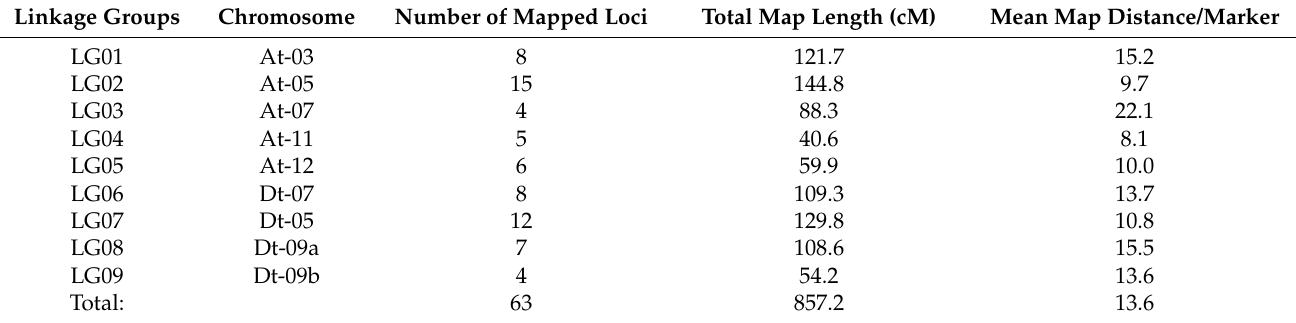
Table 4. List of genetic linkage groups constructed with the F 2 progeny.